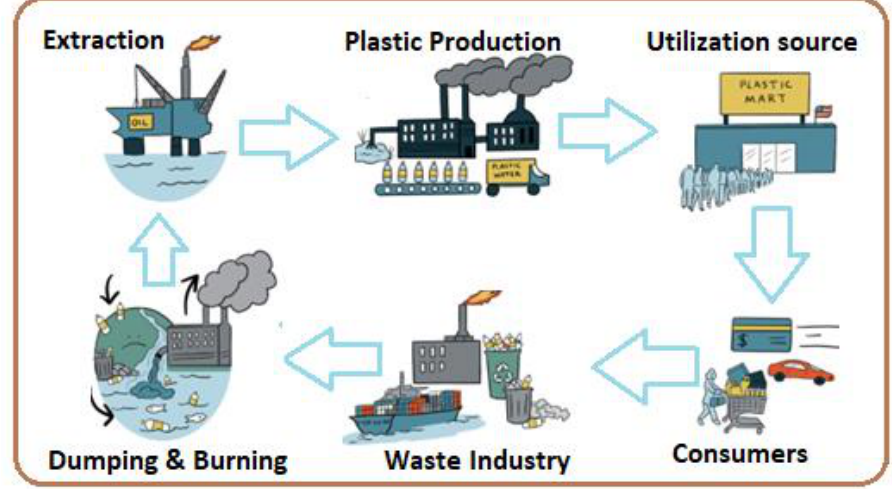
Figure 1. The entire cycle of generation, usage, consumption, dumping, and recycling of